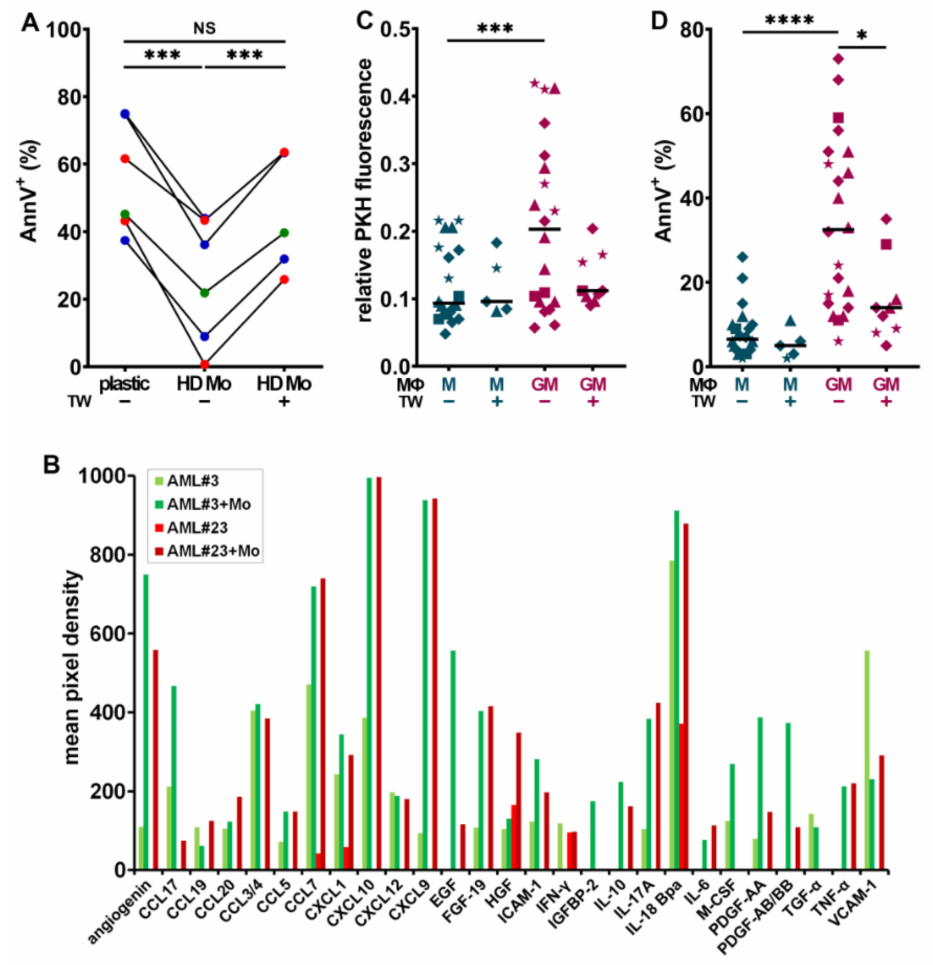
Figure 2. CD163 + M Φ s support myeloblast survival and proliferation. ( A ) Frequency of AnnV + AML blasts after 7 days of culture alone (plastic), or with monocytes either in direct contact (HD Mo) or separated by a TW. n = 6 patients (#9, 11, 17, 18, 26, and 42), color-coded ac- cording to ELN genetic risk. *** p < 0.001 (paired t -test). ( B ) Selected cytokines that were increased in CM when primary myeloblasts (favorable, green vs. high risk, red) were cul- tivated for 7 days with HD Mo vs. alone are illustrated. ( C , D ) PKH-labeled leukemia cell lines were cultured for 4 days on a monolayer of M- or GM-M Φ s and analyzed for prolifera- tion ( C ) and survival ( D ). * p < 0.05 (M-W test), *** p < 0.001, and **** p < 0.0001 (WMP test). ( (cid:70) = HL-60, (cid:4) = MV-4-11, (cid:78) = NB4, and (cid:7) =